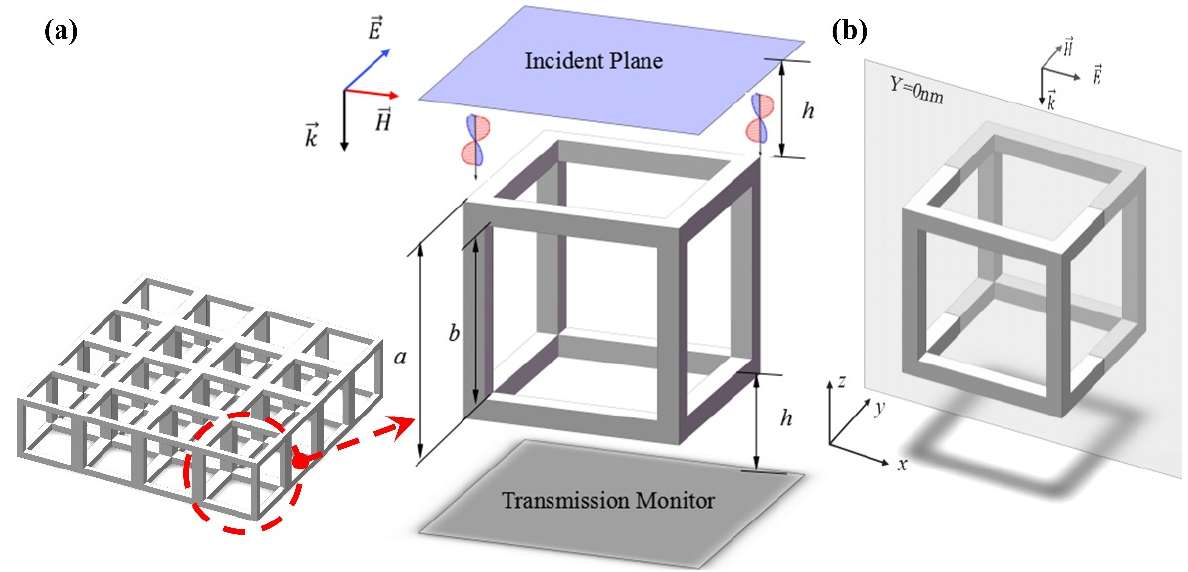
Figure 4. ( a ) Computational domain; ( b ) the research section diagram perpendicular to the direction of the magnetic field.